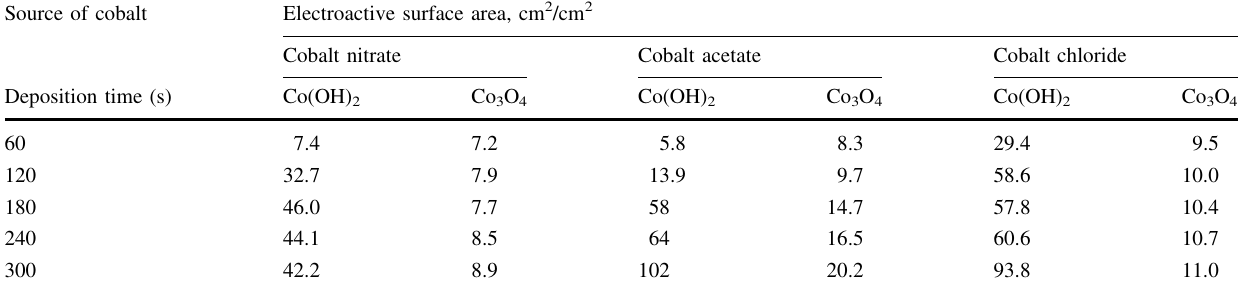
Table 3 Values of electroactive surface area of as-deposited and annealed cobalt (hydro)oxide films Source of